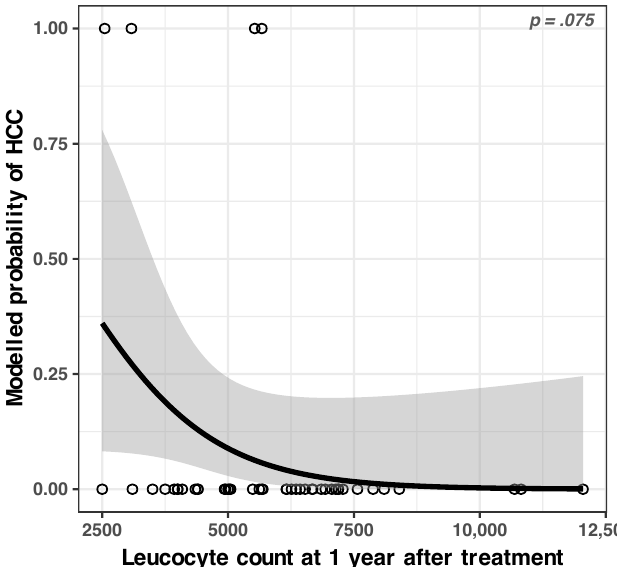
Figure 5. Modelled odds ratio (OR) of developing vs. not developing hepatocellular carcinoma as a function of leukocyte count after 1 year of treatment. The grey bands represent the 95% confidence interval; see Table A4 for the numerical